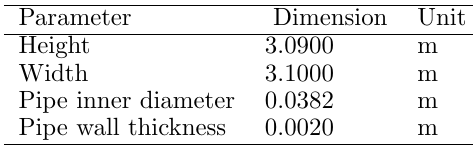
Table 1. Main geometrical data for DYNASTY.